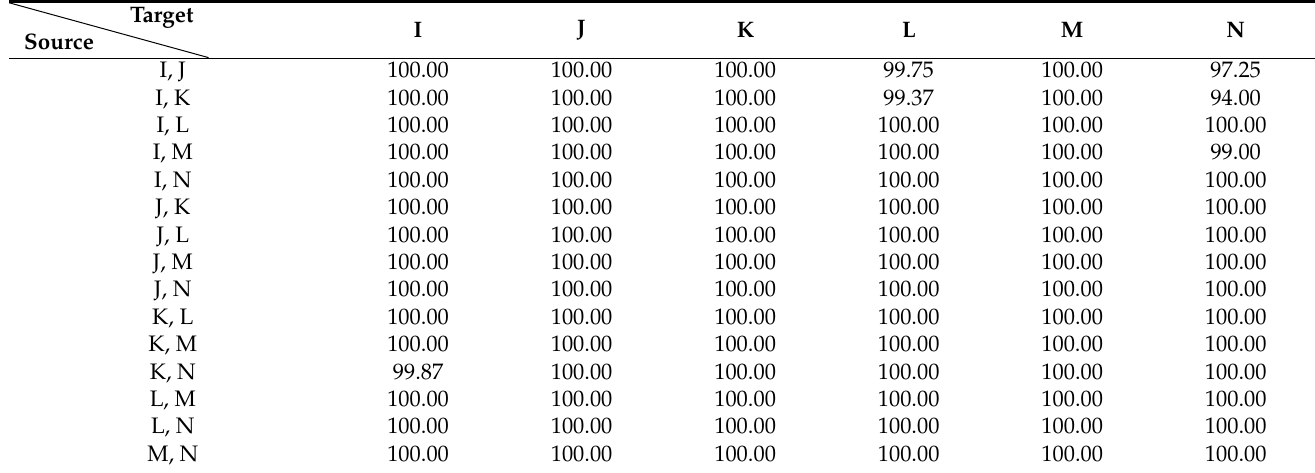
Table 3. Generalization performance of DCNG on MFPT dataset.